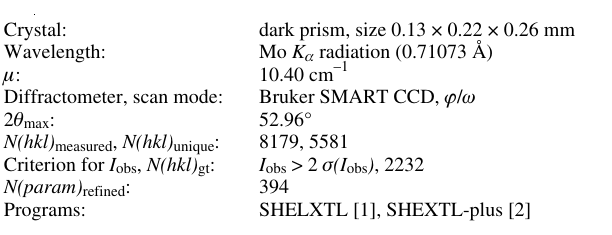
Table 1. Data collection and